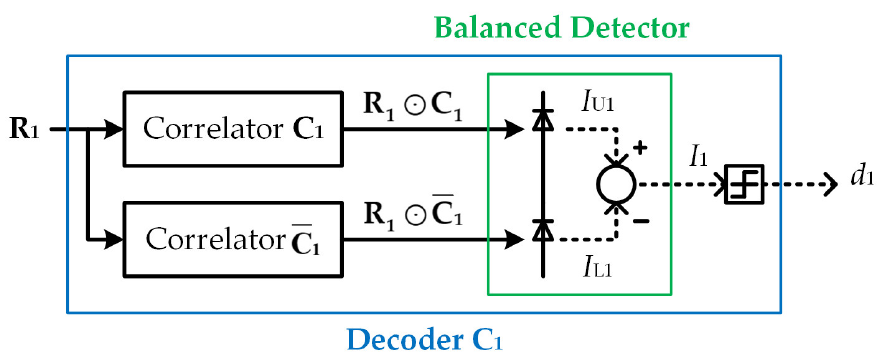
Figure 2. The decoder structure based on balanced detection for MUI estimation.